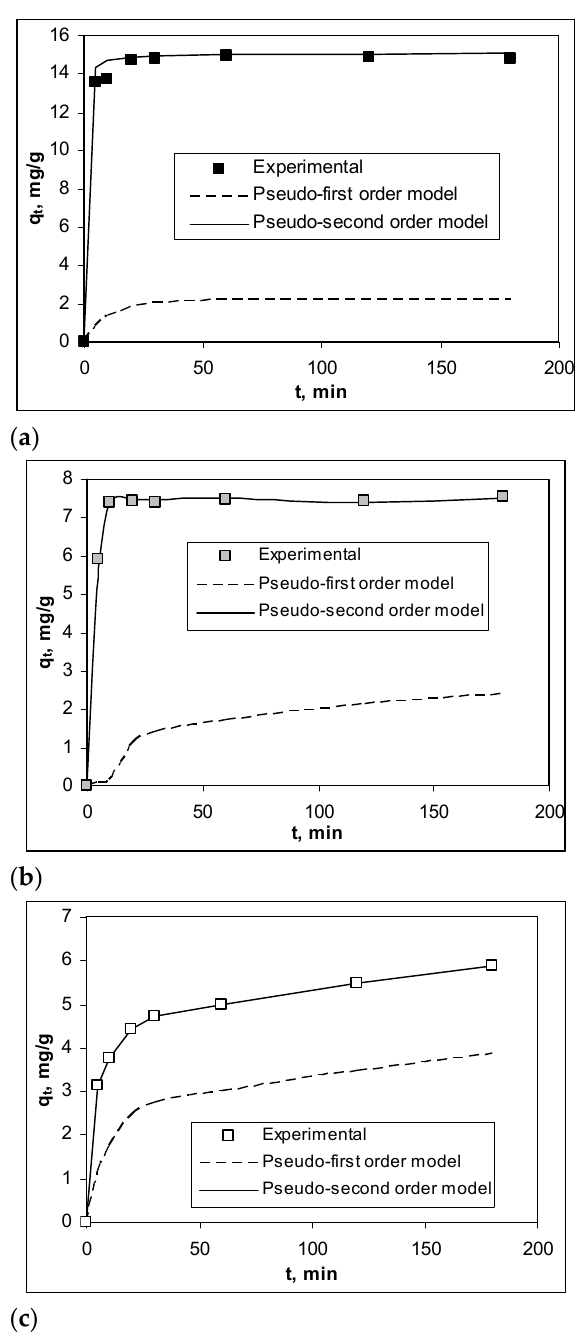
Figure 5. Experimental and modeled kinetic curves obtained for the biosorption of Pb(II) ( a ), Cd(II) ( b ), and Zn(II) ( c ) on Na-SW biosorbent.